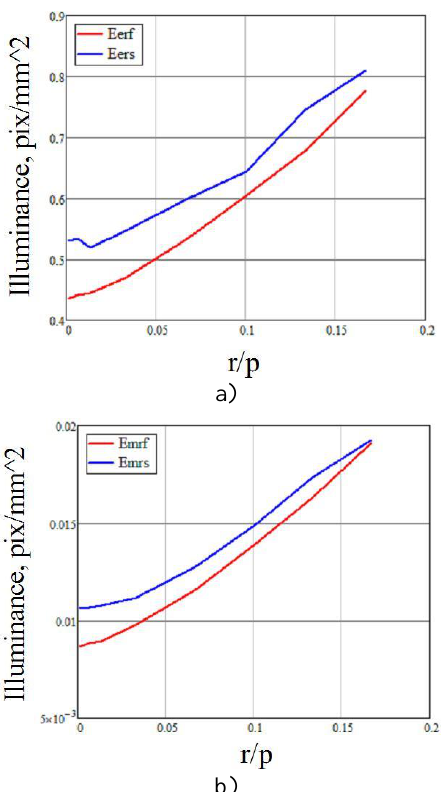
Fig. 7. Relative illuminance of external (a) and middle (b) ring of photometric images in the backscattered light for human shoulder (blue line) and finger (red line) tissue depending on the laser beam